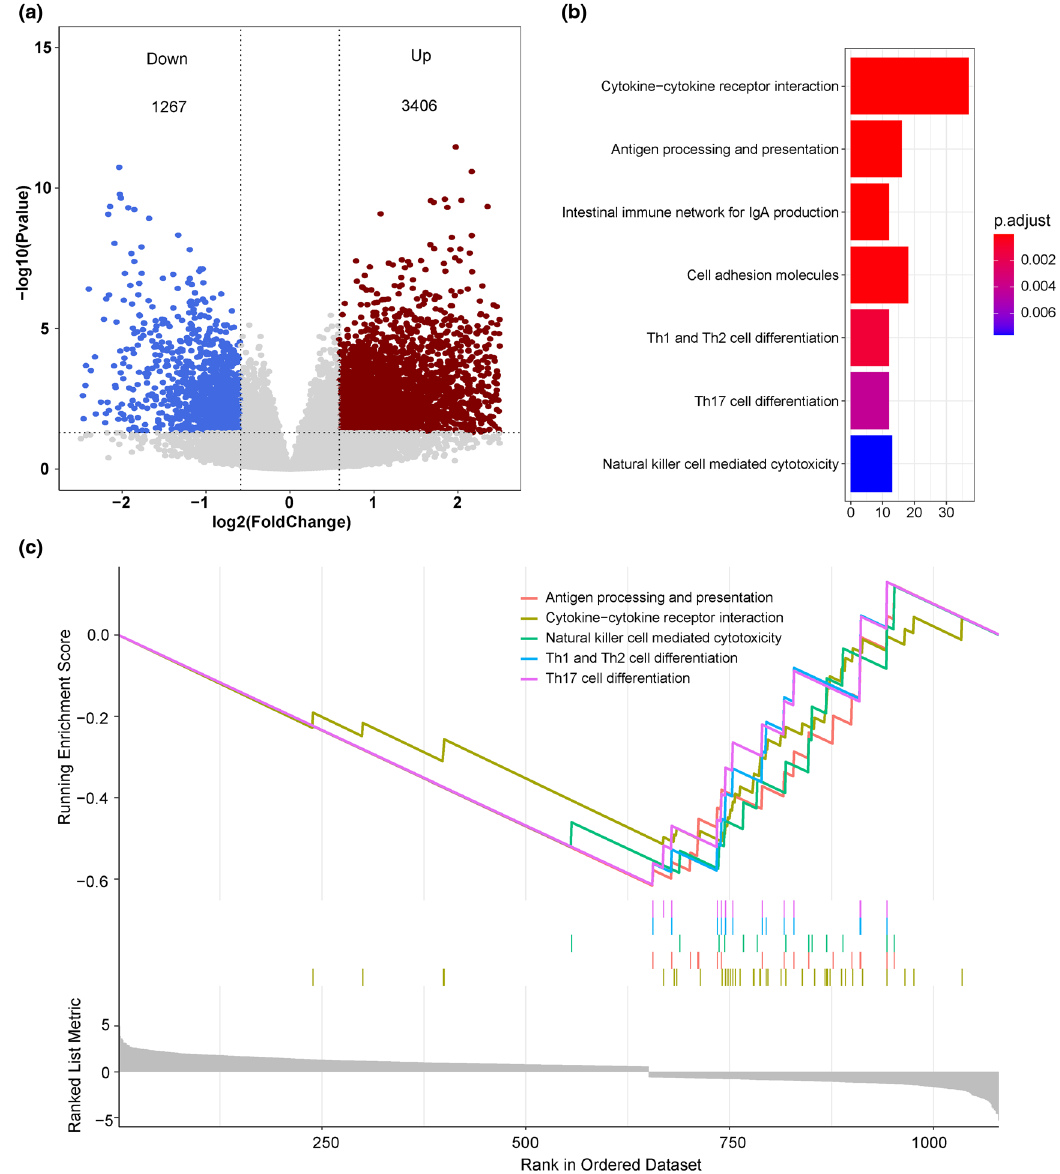
Figure 5: Mechanism exploration of the 16 - gene model in TNBC. ( a ) Volcano plot of DEGs between the high - risk and low - risk groups in the TCGA – TNBC cohort. ( b ) KEGG pathway analysis of the DEGs. ( c ) GSEA of the